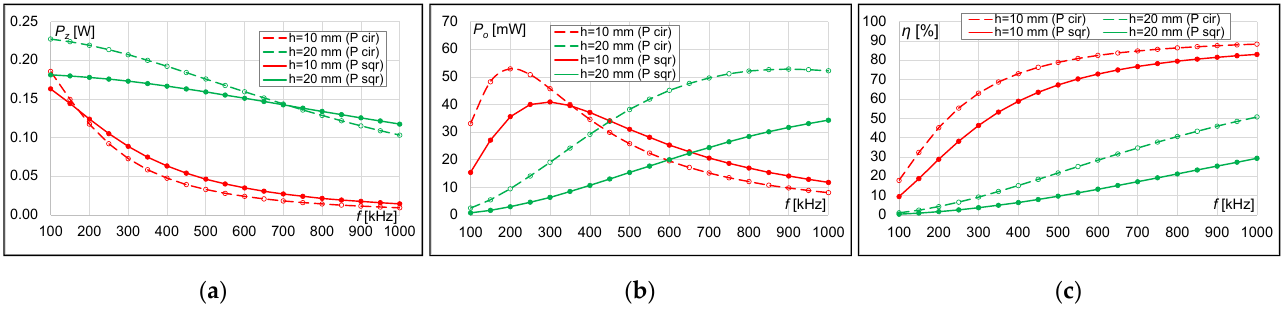
Figure 21. Results for the periodic system with circular or square coils with r = 20 mm and the number of turns n = 40 at two distances ( h = 10 mm and h = 20 mm): ( a ) transmitter power, ( b ) receiver power, ( c ) power transfer efficiency.